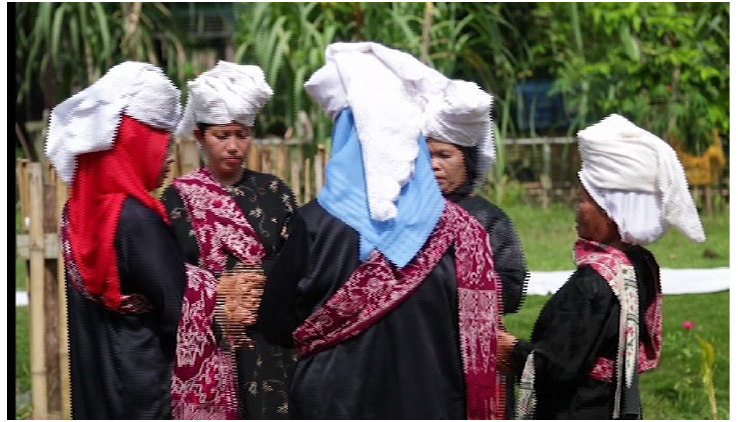
Figure 3. Bewailing in yard (source: created by